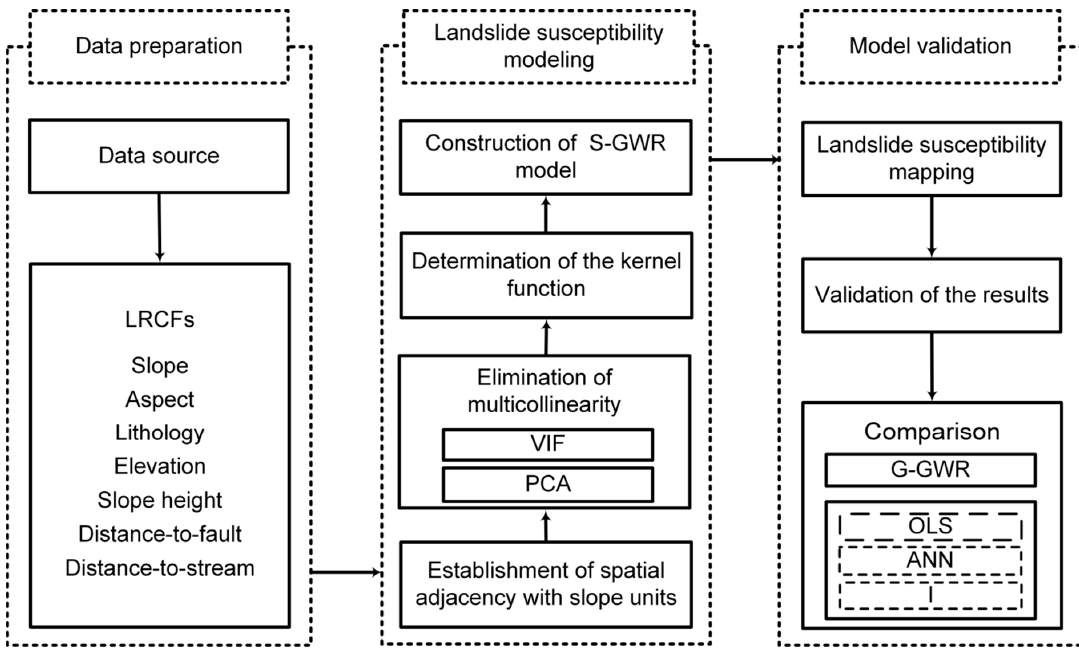
Figure 2. Methodology of research applied in this study .